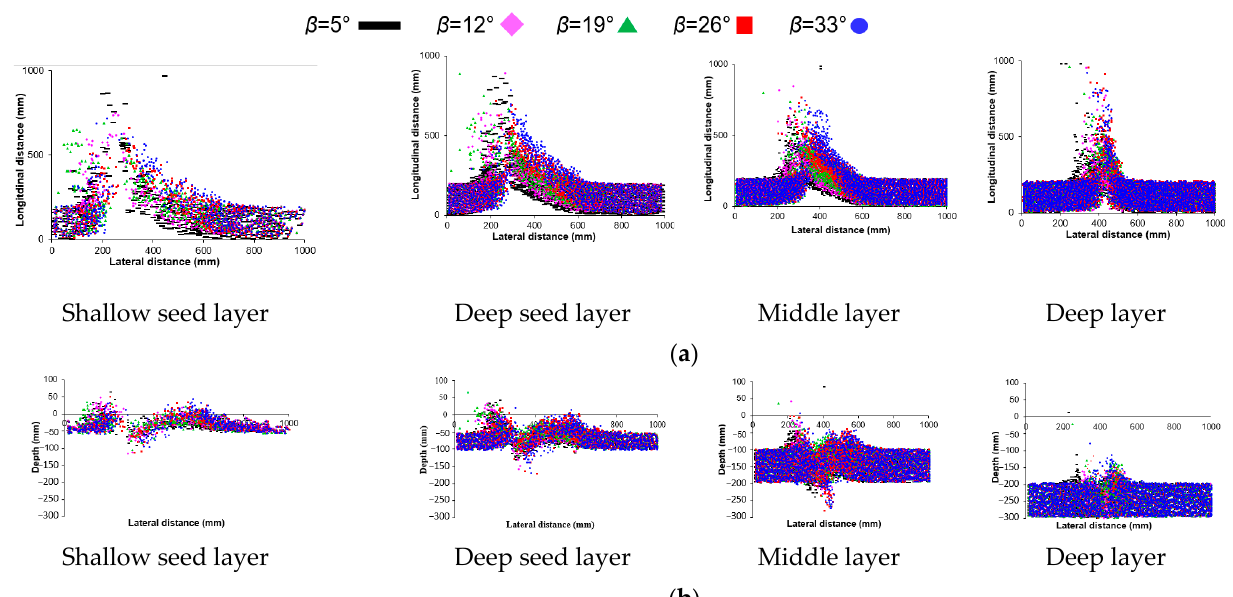
Figure 7. Lateral, longitudinal and vertical movement of particles in different soil layers, as affected by mounting angle: ( a ) Lateral and longitudinal directions; ( b ) Lateral and vertical ( i.e., depth) di- rections. depth)